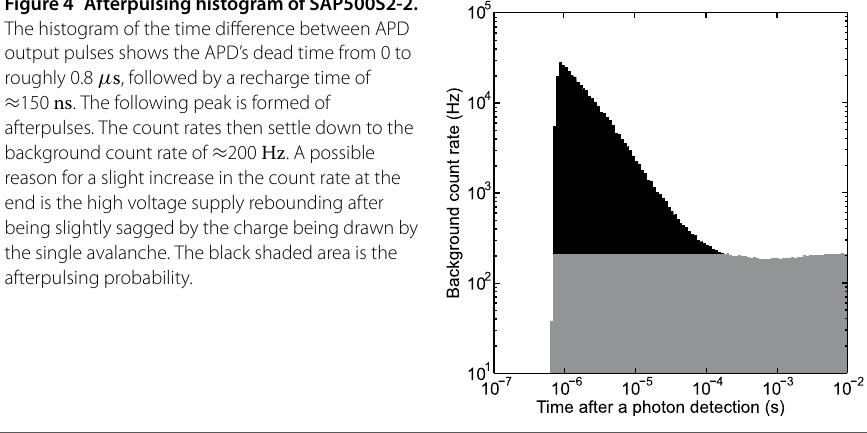
Figure 4 Afterpulsing histogram of SAP500S2-2. The histogram of the time difference between APD output pulses shows the APD’s dead time from 0 to roughly 0.8 μ s , followed by a recharge time of ≈ 150 ns . The following peak is formed of afterpulses. The count rates then settle down to the background count rate of ≈ 200 Hz . A possible reason for a slight increase in the count rate at the end is the high voltage supply rebounding after being slightly sagged by the charge being drawn by the single avalanche. The black shaded area is the afterpulsing